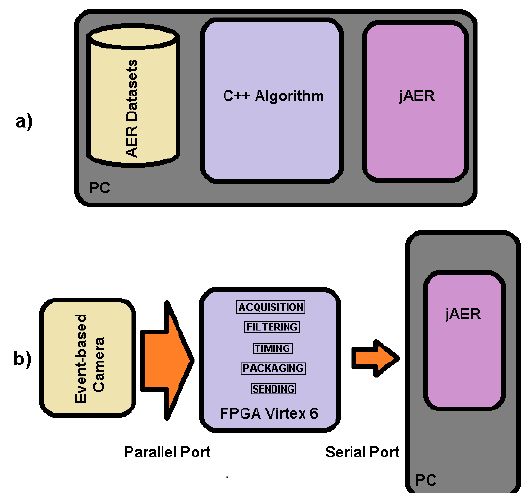
Figure 1. Procedures used to develop and test the LDSI algorithm: ( a ) offline configuration, where, from left to right, AER dataset recorded with event-based cameras was read and applied to the PC programmed LDSI algorithm whose results were provided to jAER for visualization; and ( b ) online testing, where an event-based camera was connected through its parallel port to an FPGA where the LDSI algorithm was computed and output data were properly encapsulated and sent to a PC for visualization and data-logging through a serial